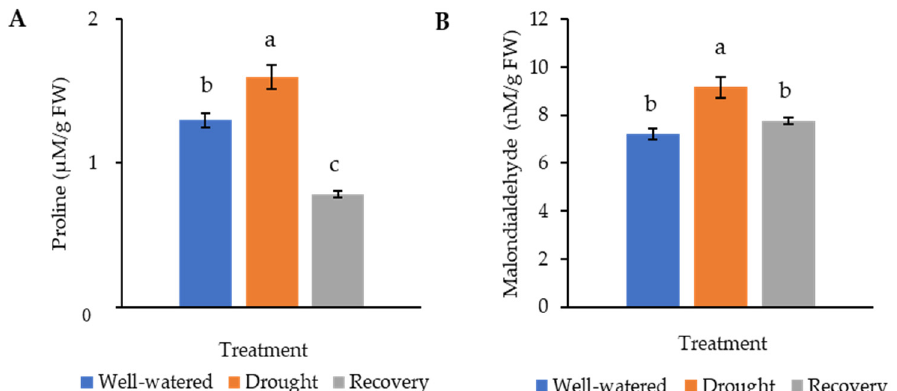
Figure 5. Osmolyte and lipid peroxidation changes of the drought-stressed and well-watered Pan- danus amaryllifolius . ( A ) Proline content of P. amaryllifolius leaves as quantified in μ M g − 1 fresh weight (FW). ( B ) Malondialdehyde (MDA) content of P. amaryllifolius leaves as quantified in μ M g − 1 FW. Means labeled with alphabet were significantly different based on the ANOVA followed by post hoc when its p -value < 0.05.